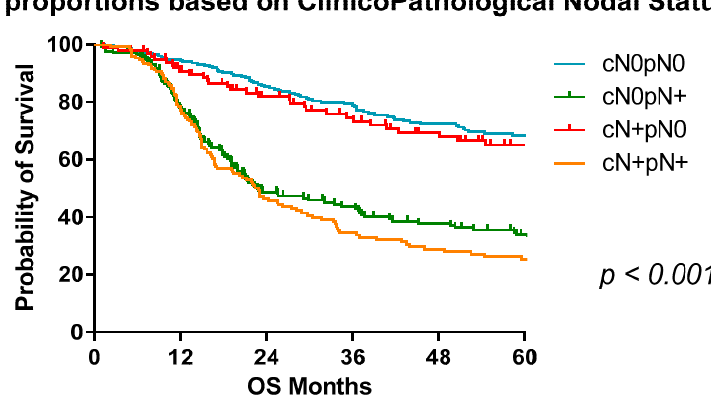
Figure 2. Survival proportions of OAC patients based on clinicopathological nodal status. Median survival: cN0pN0, not reached; cN+pN0, 124.6 months; cN0pN+, 22.93; cN+pN+, 22.5 months.